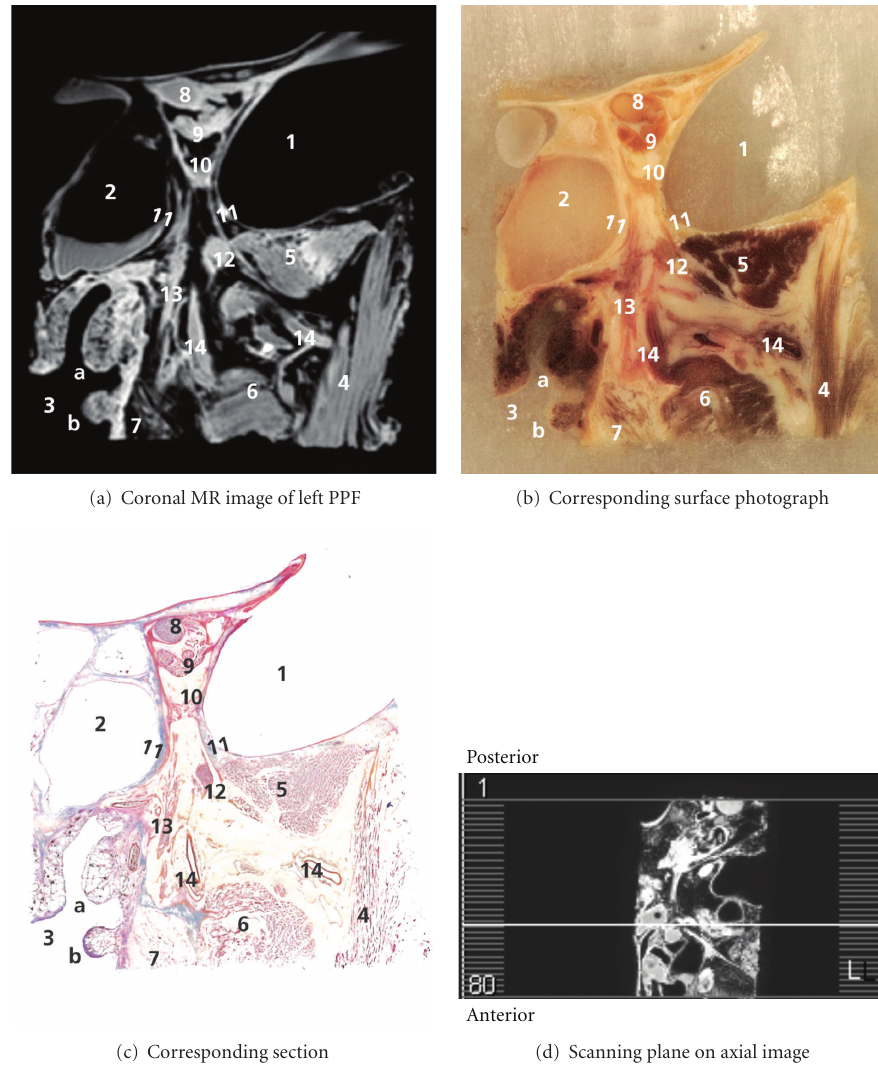
Figure 2: 1–10: see Figure 1. 11: orbital PPG branches, 12: maxillary nerve, 13: greater palatine nerve, and 14: maxillary artery continuing as sphenopalatine